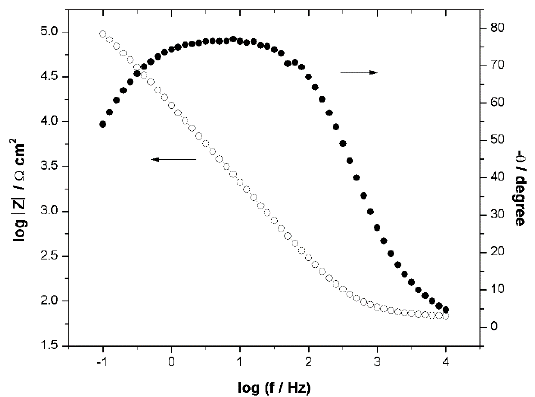
Figure 3. Bode impedance plot for Ti6Al4V/oxide system. The dc potential was the open circuit potential: ~0.380 V at room temperature.